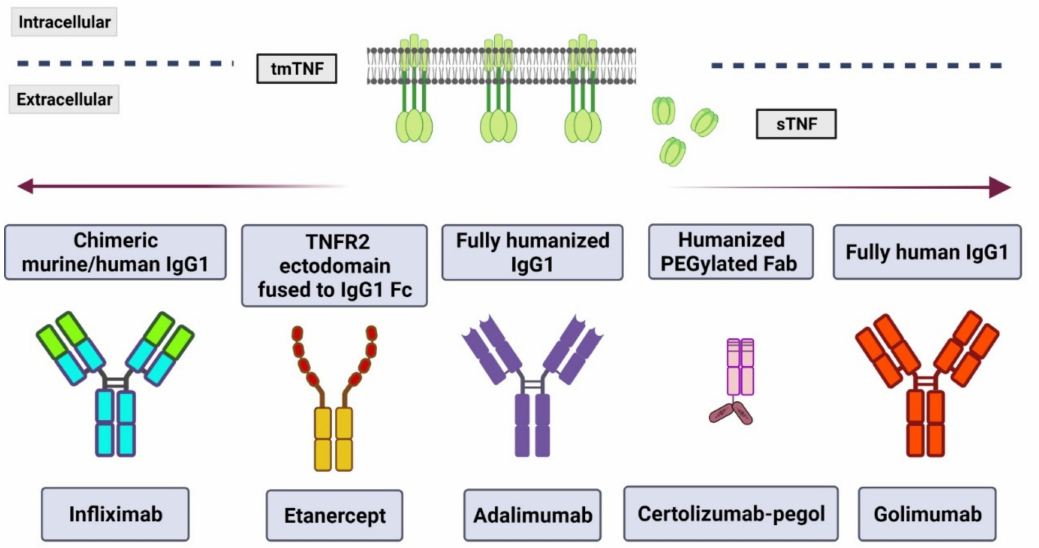
Figure 2. TNF inhibitors approved for therapeutical use. Currently, there are five monoclonal antibodies used in anti-TNF therapy; each one has a specific structure and origin. However, all of them neutralize both transmembrane (tm) and soluble (s) TNF. (Figure created with BioRender.com, accessed on 21 April